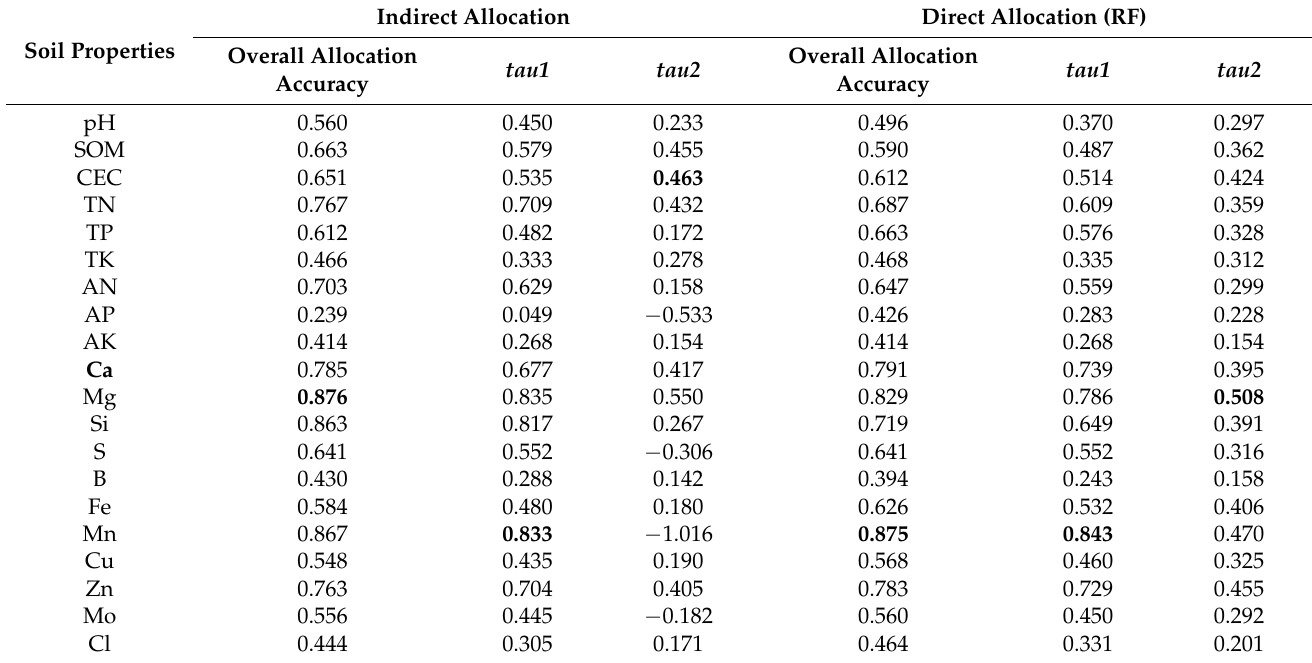
Table 12. Comparison between direct allocation and indirect allocation (five fertility